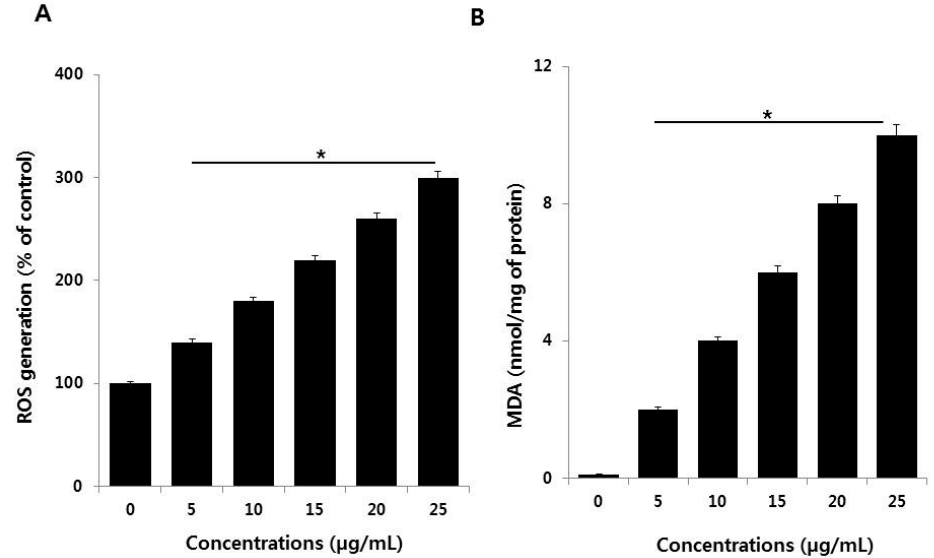
Figure 7. Measurement of ROS generation and malondialdehyde (MDA) in NIH3T3 cells. ( A ) NIH3T3 cells were treated with or without AgNPs for 24 h, and ROS generation was measured using DCFH-DA. ( B ) NIH3T3 cells were treated with AgNPs for 24 h. Lipid peroxidation was determined by the reaction of MDA with thiobarbituric acid to form a colorimetric (532 nm)/fluorometric (excitation and